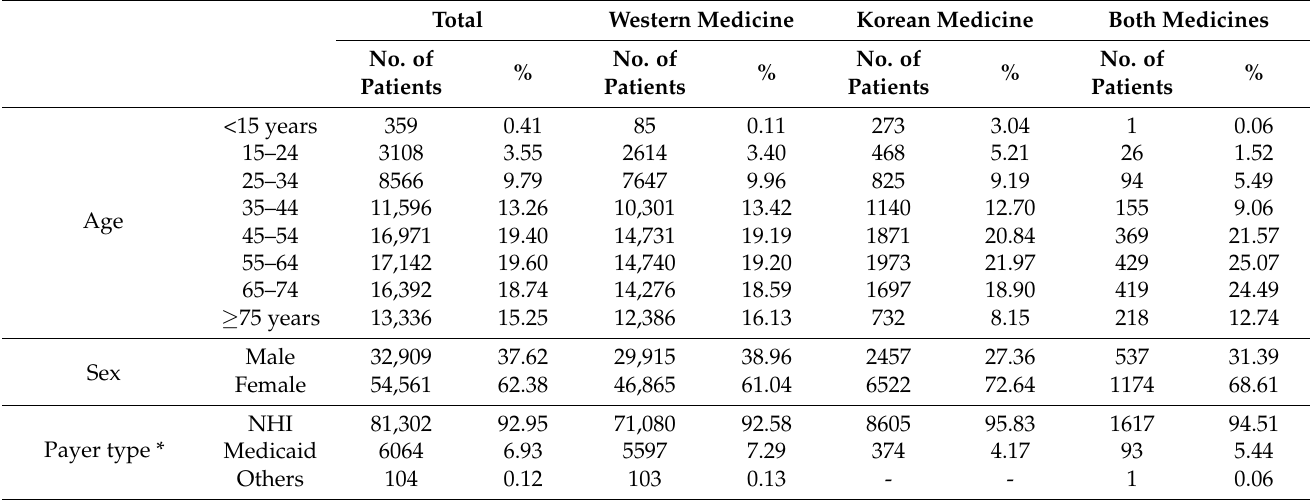
Table 2. Basic characteristics of patients.